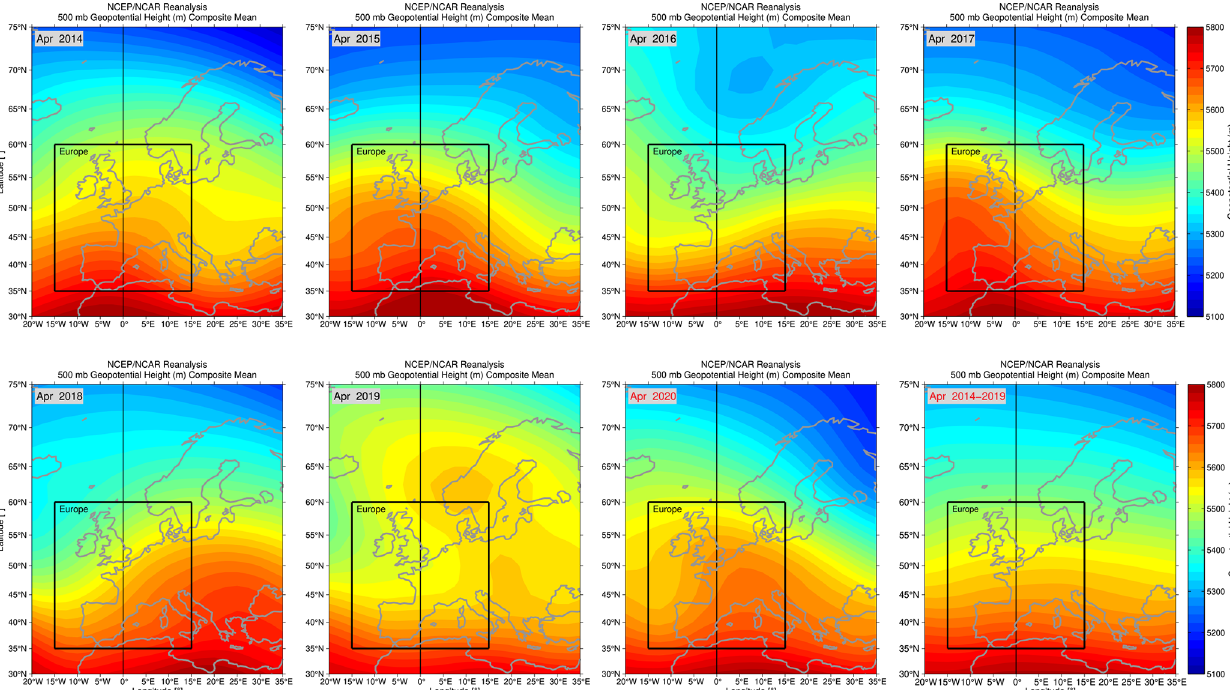
Figure 2. Same as Fig. 1 but for 500mb geopotential height composite mean in